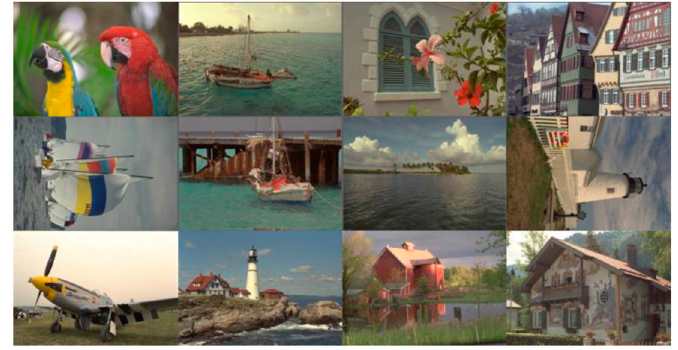
Figure 9. Kodak image set (12 images).